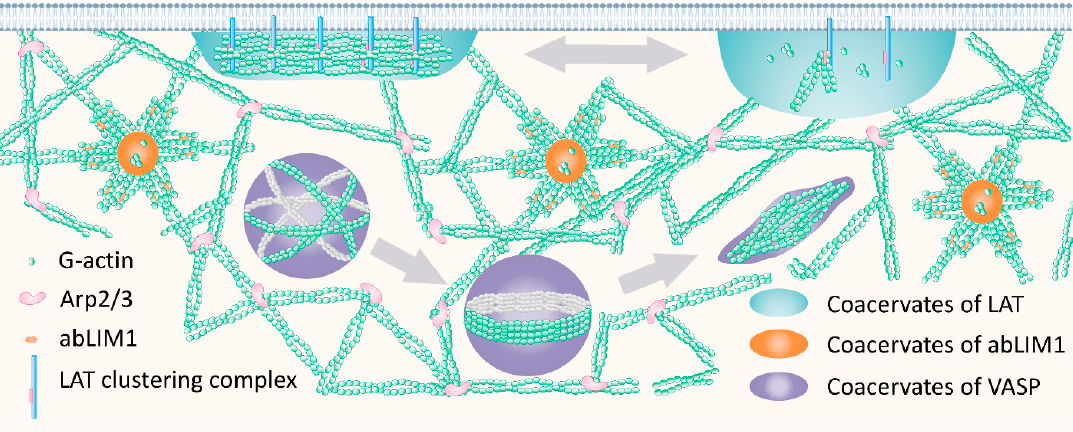
Figure 4. The currently discovered, coacervate-dependent models of actin polymerization and bundling. The figure was created based on the results of the works [2,27,53]. Actin filaments are known to be associated with the membrane. Within the framework of new ideas of actin polymerization, it becomes clear that this is energetically favorable since the threshold concentration of coacervate formation on the membrane is an order of magnitude lower than in free space [54]. New ideas about actin polymerization reveal new directions in the study of the cytoskeleton and formulate new challenges for researchers. It remains to be seen whether some other actin-binding proteins can form coacervates during phase separation and under which scenario they will work, similar to how the abLIM1 or VASP coacervates interact with formed filaments [3]. It is interesting to evaluate the existence of proteins that can form coacervates similar to signaling proteins in response to internal cell stimuli. the concentration of tubulin in centrosomes [4], recent works on actin polymerization highlight the universal role of LLPS in the formation of the cytoskeleton. Researchers are now challenged to explore the dynamic cytoskeletal organization within the frame of this new